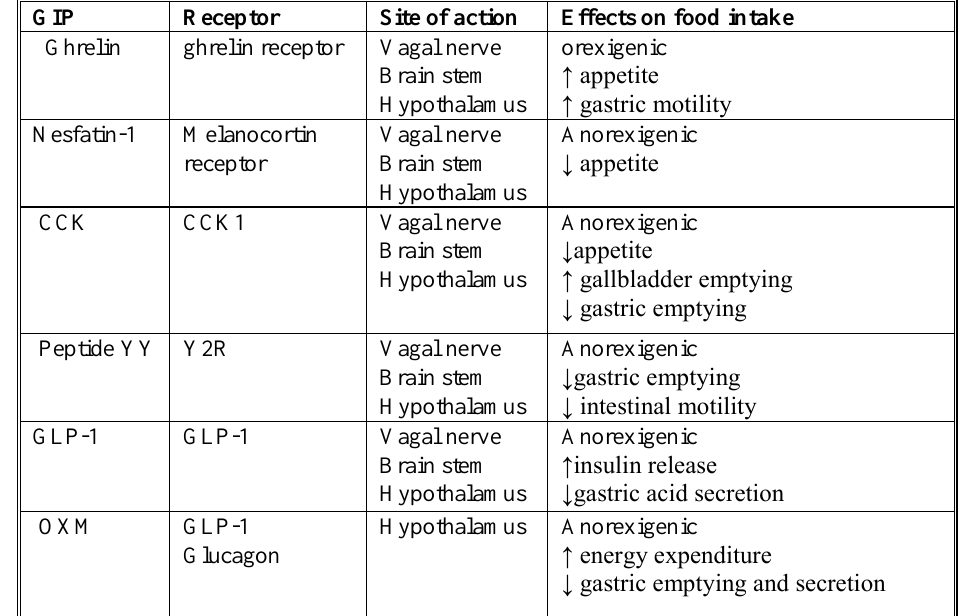
Table1. GIP activities in food intake control